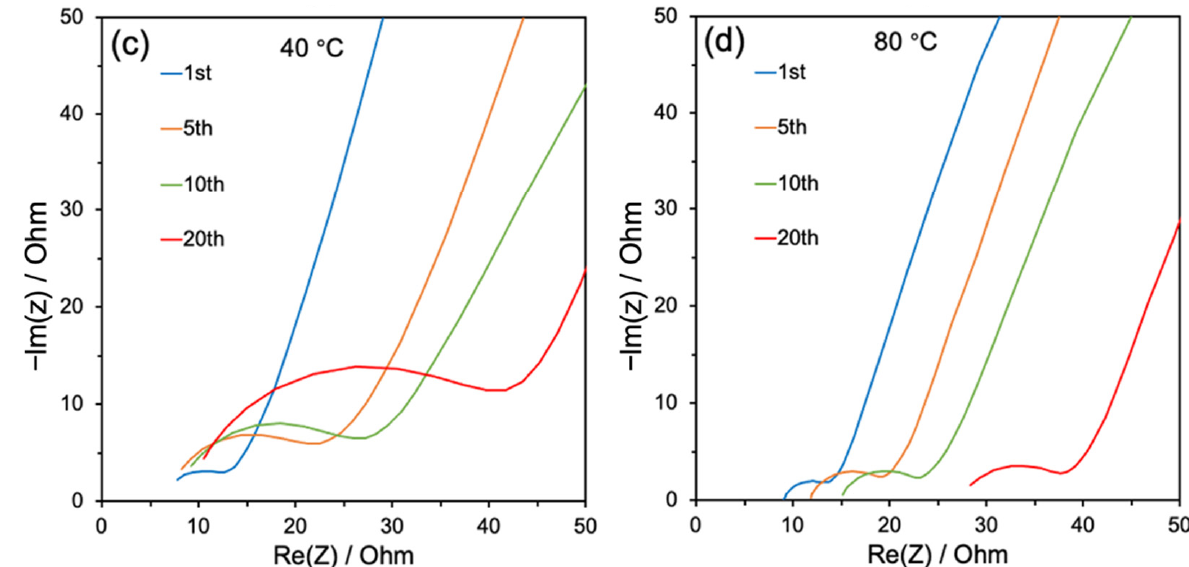
Figure 7. Nyquist plots of HC electrode after different numbers of cycles at 100 mA g − 1 ( a ) 10 °C, ( b ) 25 °C, ( c ) 40 °C and ( d ) 80 °C.